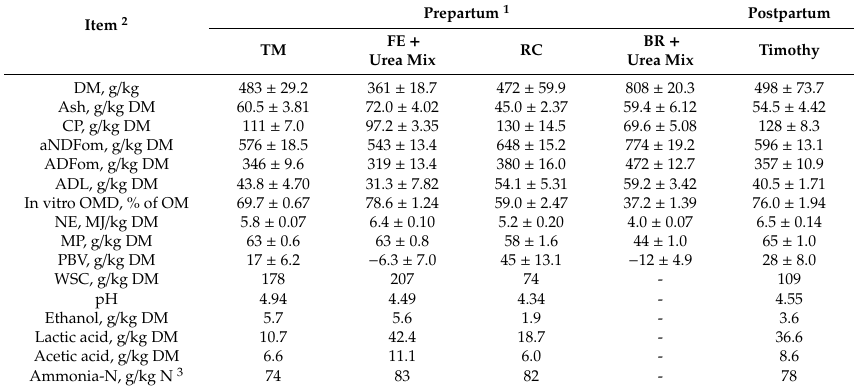
Table 1. Nutritional characteristics (mean ± SD) of the experimental roughages fed ad libitum